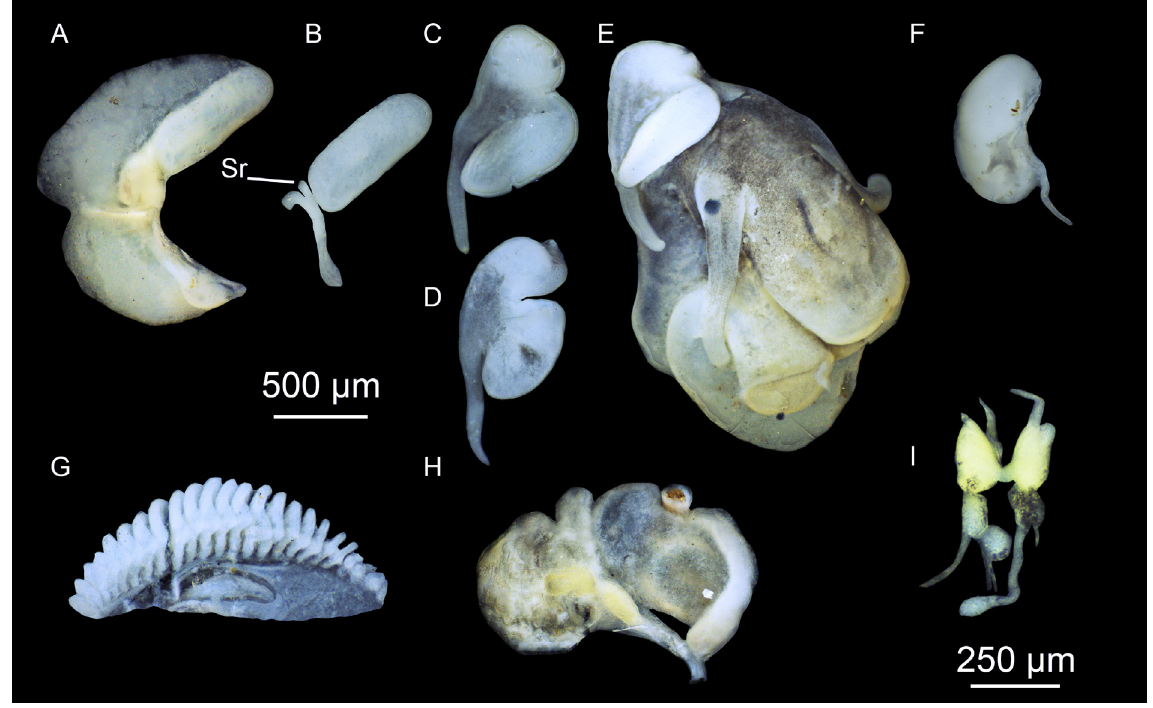
Fig. 22. Anatomy of Mercuria carrillorum Miller, García-Guerrero & Ramos sp. nov. from the